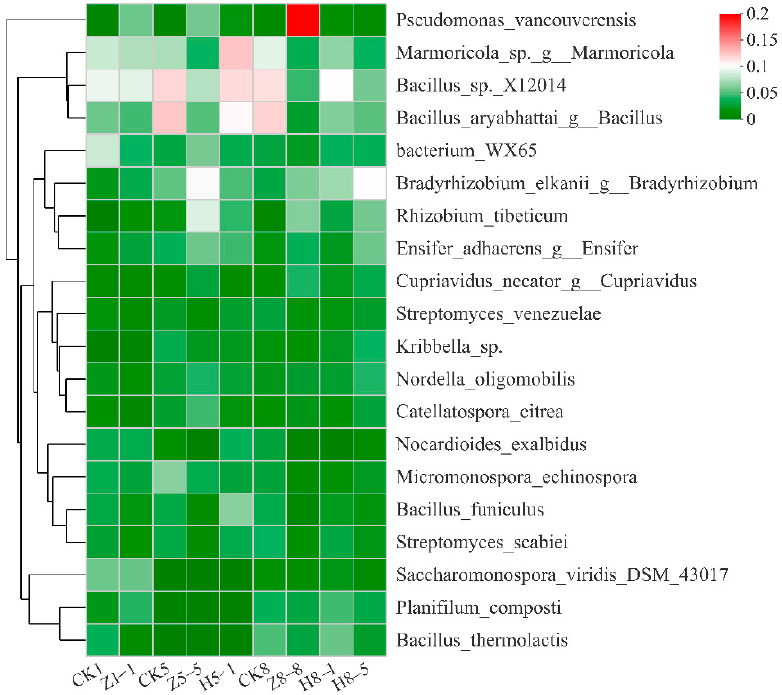
Figure 9. Heat map of bacterial species with top 20 relative abundances in soil in different years of growing and replanting. Note: The nomenclature for each sample is the same as that in Table 2.